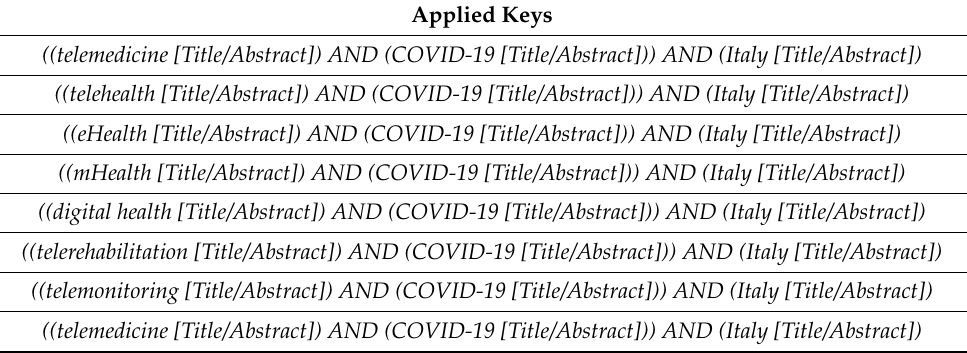
Table 2. The keys applied in the search (COVID-19 was also changed with SARS-Cov-2 during the